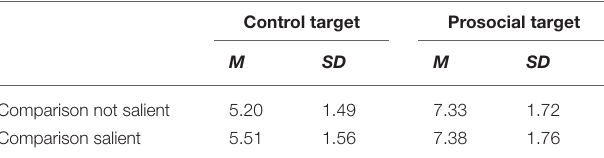
TABLE 3 | Mean target communal narcissism ratings per condition in Experiment